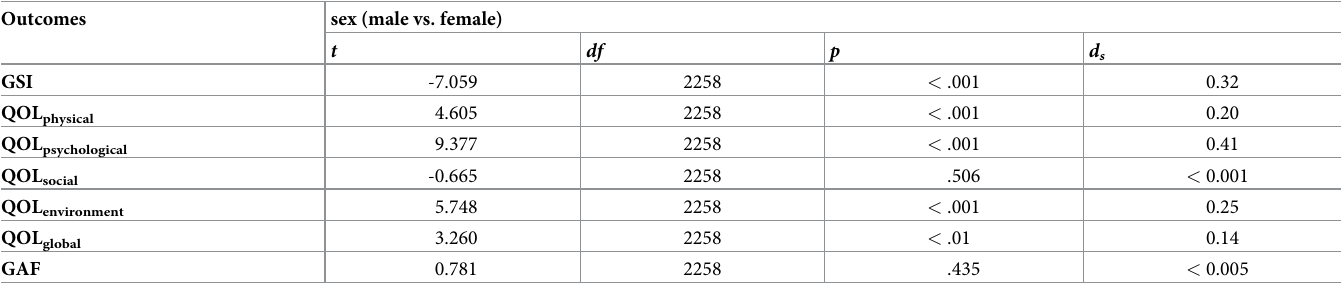
Gender differences in changes between T1—T2 The course of treatment for men and women was compared with the help of a repeated mea- sures ANOVAs, controlling for the differences in symptom burden at the time of admission (T1). Table 4 reports the results of the 2 (time) × 2 (gender) ANOVAs per outcome variable. Treatment effects were gender-specific (= significant interaction between the factors time × gender) for general symptom burden (GSI) and quality of life in the physical and psy- chological domain (QOL , QOL ), as well as functional ability (GAF). Functional physical mental ability showed a more pronounced improvement in men; the other two measures showed Table 3. Group comparison of outcomes at admission (time